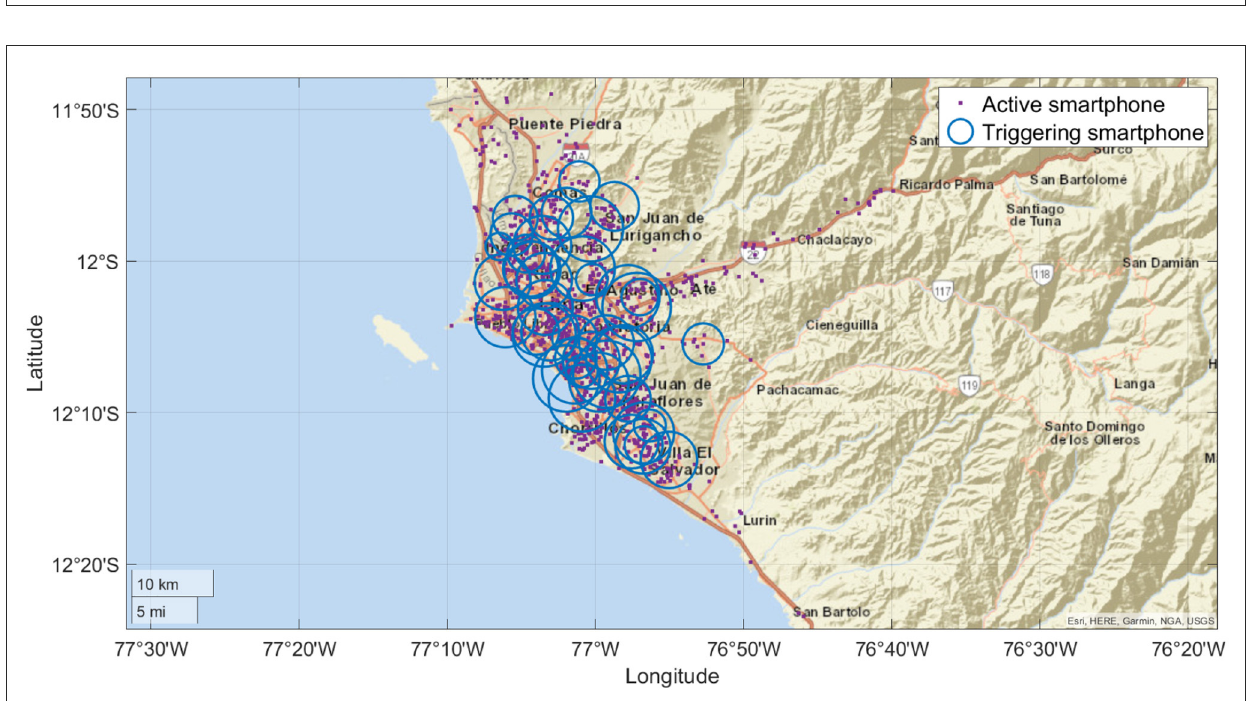
FIGURE2 Simulated false earthquake detection based on the EQN smartphone network of Lima (Peru). The diameter of circles is proportional to the triggering time.